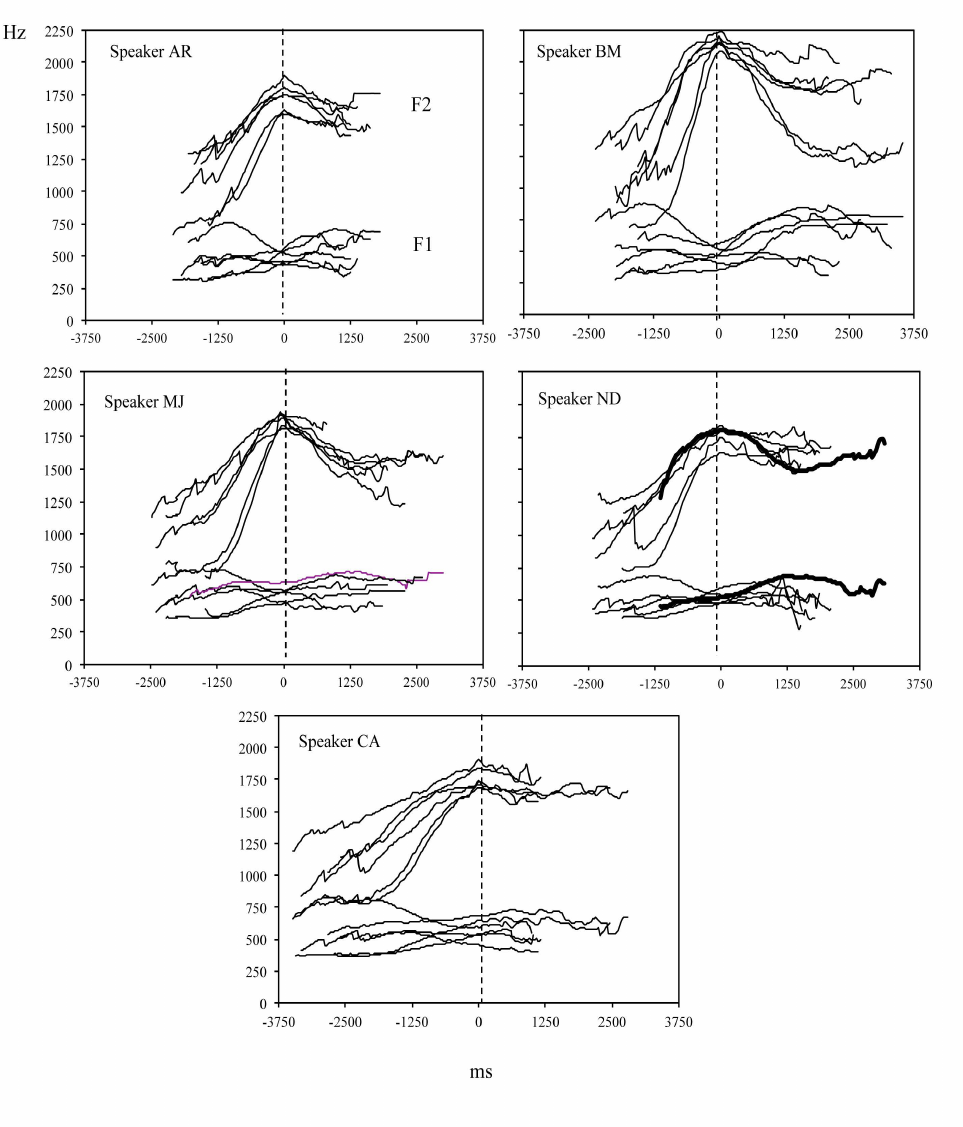
FIGURE 6. Mean F1 and F2 trajectories across repetitions of the six [VjV] sequences under analysis for each of the Majorcan speakers AR, BM, MJ, ND and CA. Formant trajectories have been lined up at the F2 frequency maximum. The thick trace in the right middle graph corresponds to the sequence [e  ja] of the word roveiat according to speaker